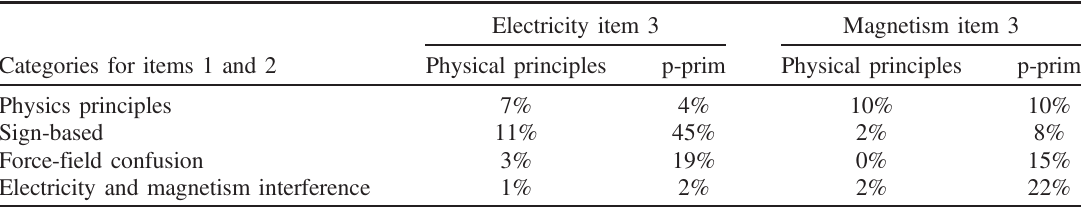
TABLE IV. Consistency analysis of the total test, comparing answers in items 1 and 2 with responses in item 3 for each test